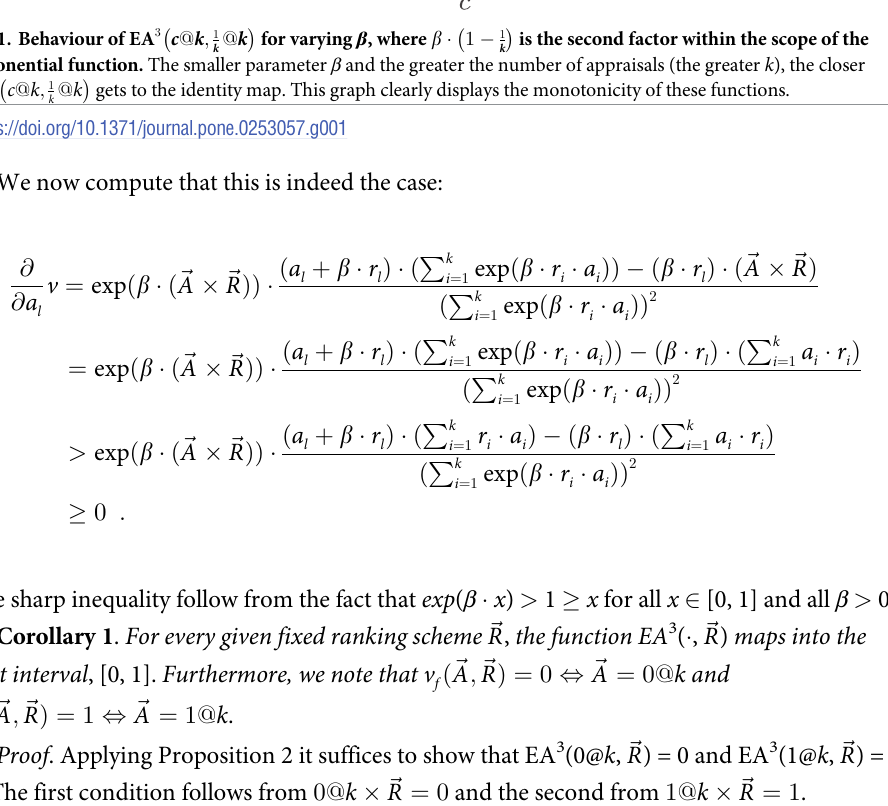
(cid:0) � is the second factor within the scope of the k